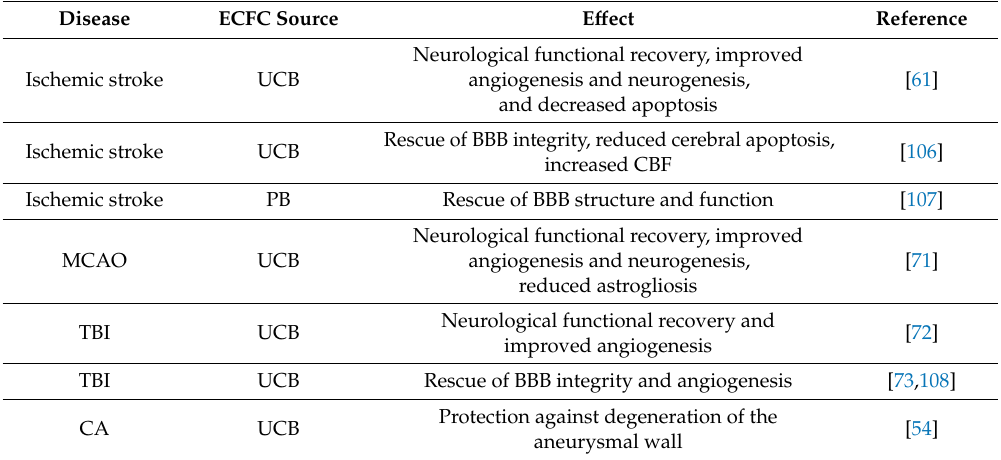
Table 1. Preclinical applications of endothelial colony-forming cells